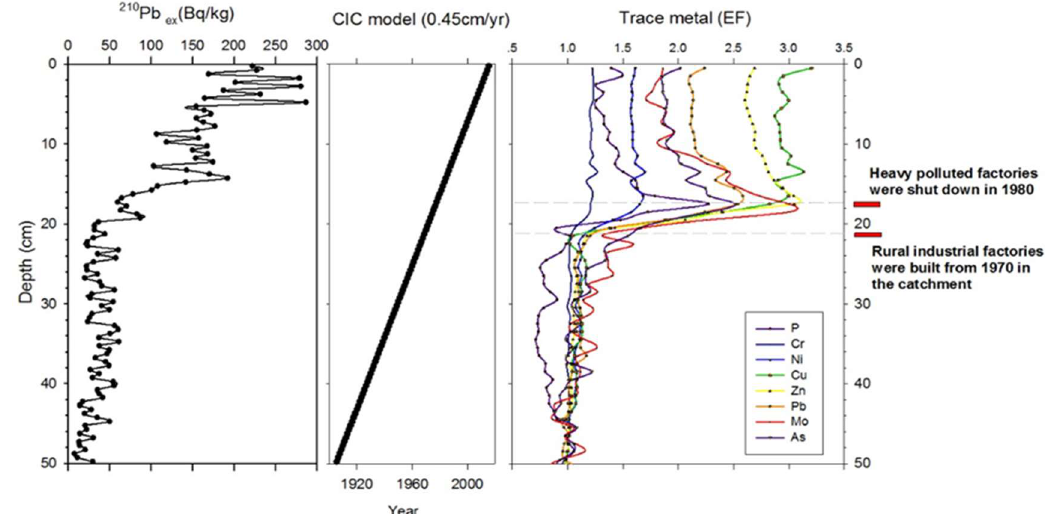
Figure 2. The constant initial concentration (CIC) profile of the 210 Pb activity, age-depth model, and trace metals and other elements in the sediment core of the Changdang Lake. All trace metals increased abruptly at 20 cm and then plateaued around 15 cm in the sediment core. These results coincide with the initial industrial period in 1970 across the catchment. Most factories were forced to shut down or were asked to reform in the 1980s due to high water pollution. The records indicate that the depths of 20 cm and 15 cm in the core correspond to 1970 and 1980, respectively, which is also consistent with the 210 Pb results.